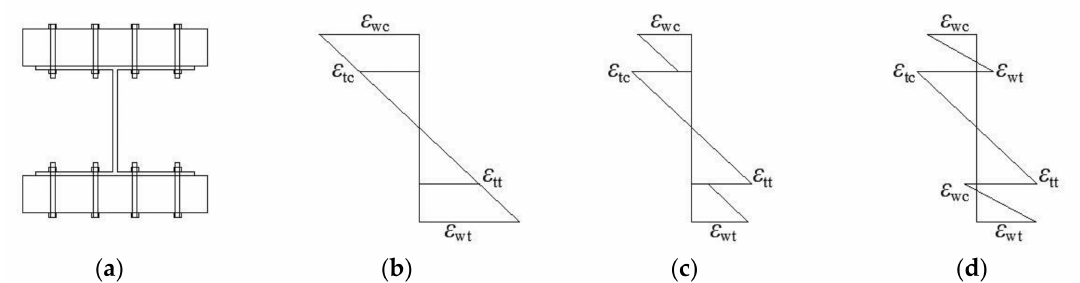
Figure 10. Schematic diagram of normal strain in the cross-section of the composite beam: ( a ) composite beam; ( b ) fully rigid connection; ( c ) strong composite connection; ( d ) weak composite